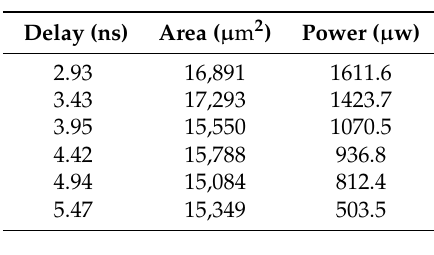
Figure 13. Proposed architecture obtained by synthesis. Figure 12. Proposed architecture obtained by synthesis. Table 2. Area, delay and power consumption for the 10-class softmax layer output of a convolutional neural network (CNN). (a) Architecture of Figure 2a.